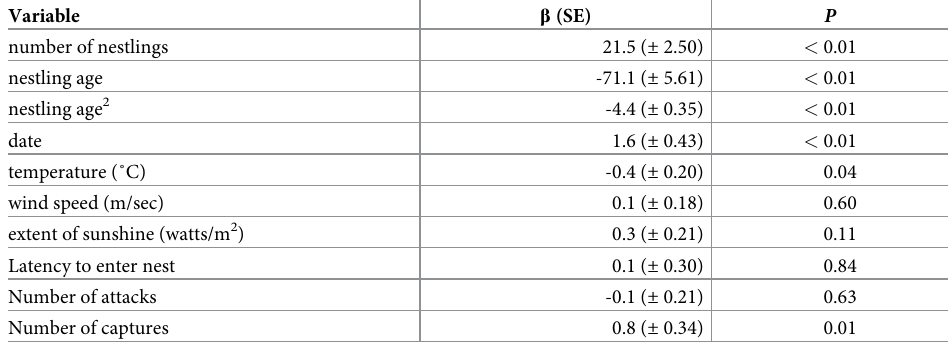
Nest ID and colony Site ID were modelled as random effects. n nests = 112 and n sites =